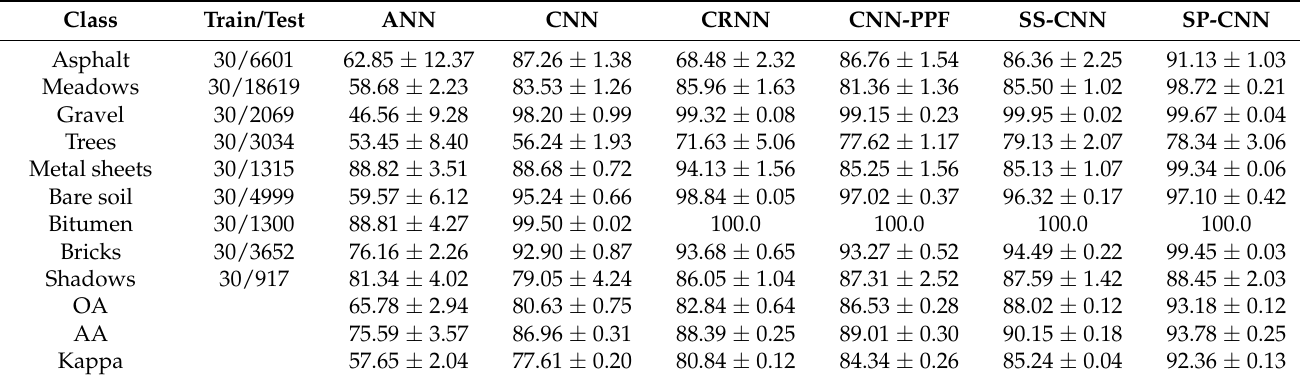
Table 3. Statistical results of six methods on Pavia University dataset.